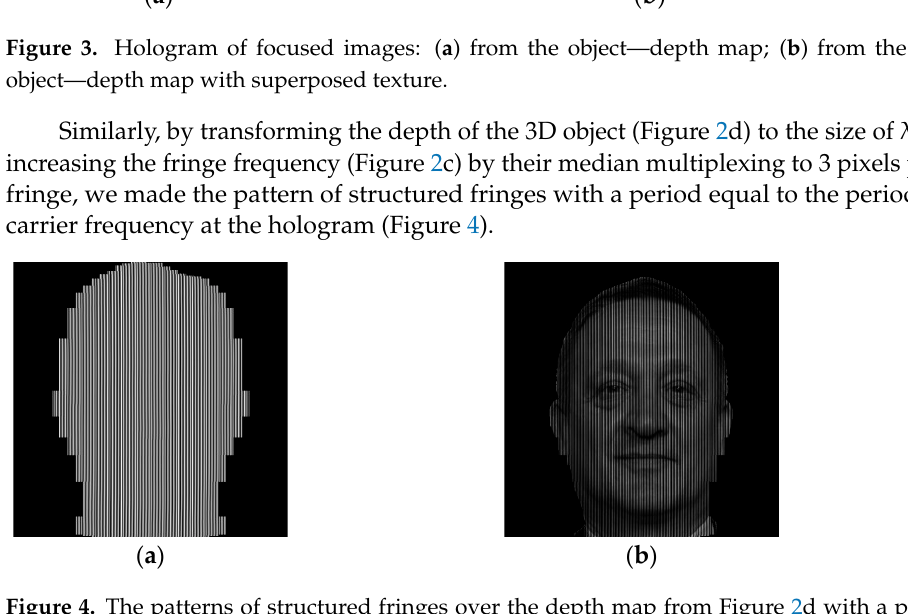
Figure 4. The pa tt erns of structured fringes over the depth map from Figure 2d with a period of 3 pixels and the depth reduced to λ /2: ( a ) vertical structured fringes are projected onto the mask, ( b ) the fringes superposed on the mask are stitched on the texture.